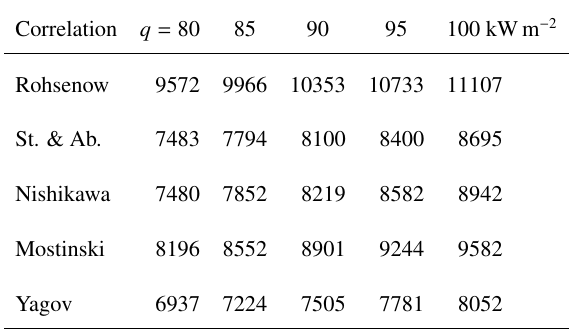
Table 2. Heat-transfer coe ffi cient α (Wm − 2 K − 1 ) estimated from correlations for di ff erent heat fluxes q (kWm − 2 )